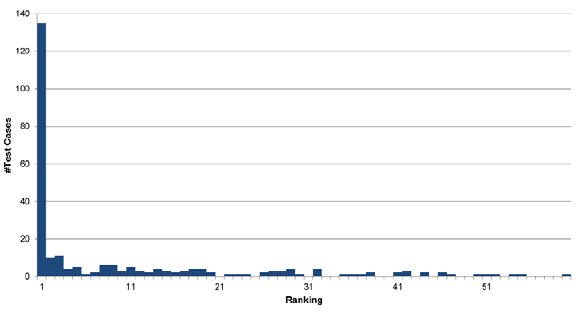
Figure 4. Evaluation of tissue-disease association prediction. The histogram shows the distribution of our disease-tissue ranking for the tissues assigned by Lage et al. in every test case (disease-gene association). As can be seen, in more than half of the cases the associated tissue was predicted first among all other